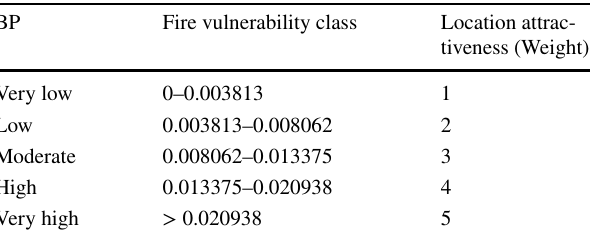
Fig. 2 Flowchart of the proposed methodology for spatial resilience to wildfires Table 1 Burn probability (BP) and degree of fire vehicle location attractiveness (weight) for each geographical unit in the Chalkidiki study